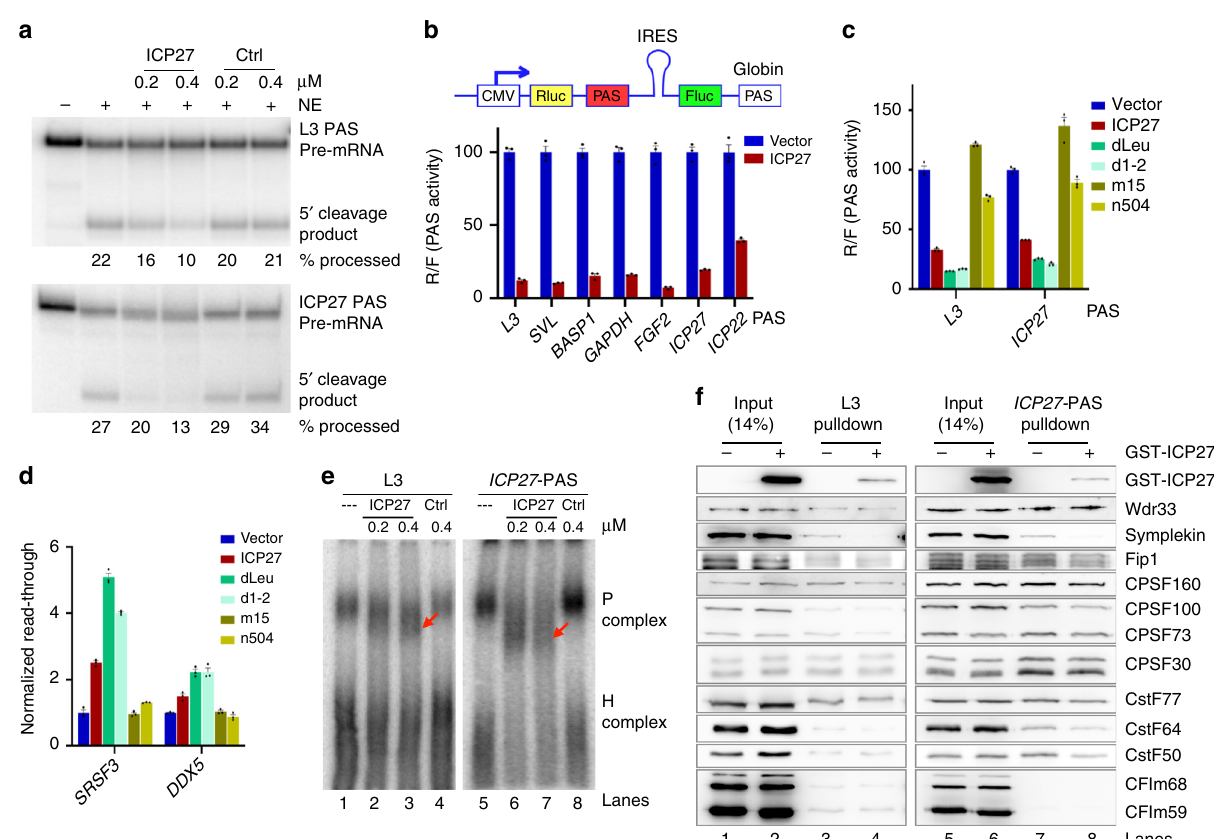
Fig. 4 ICP27 inhibits mRNA 3 ′ processing. a In vitro cleavage assay with HeLa nuclear extract (NE) using L3 (top panel) or ICP27 (lower panel) PAS pre- mRNA substrate. 5 ′ cleavage product is marked. Different amounts of recombinant MBP-ICP27 (labeled as ICP27) or MBP-MS2 (Ctrl) were added to NE. b Dual luciferase reporter assay. The top panel is a diagram for pPASPORT vector and the site where the PAS to be tested is inserted is marked as PAS (in a red box). Seven distinct PASs were cloned into pPASPORT, co-transfected with a vector or ICP27-expression plasmid. The Rluc/Fluc ratio, which measures cleavage/polyadenylation ef fi ciency at the test PAS, are plotted as mean ± s.d. c pPASPORT assays with L3 and ICP27 PAS. Empty vector, ICP27 or its various mutants were co-expressed with the pPASPORT constructs and renilla/ fi re fl y luciferase ratio was plotted as mean ± s.d. d Empty vector, ICP27 or its various mutants were transiently expressed and transcription read-through at the SRSF3 and DDX5 genes were measured by qRT-PCR and plotted as mean ± s.d. e In vitro cleavage/polyadenylation reactions (similar to a ) were resolved on a native gel and visualized by phosphorimaging. The mRNA 3 ′ processing complex (P complex) and the heterogeneous complex (H complex) are marked. f 3MS2-L3 or 3MS2-ICP27 PAS RNA substrates are incubated under cleavage/polyadenylation conditions and the assembled RNP complexes were pulled down by using amylose beads and analyzed by western blotting. Source data are provided as a Source Data fi